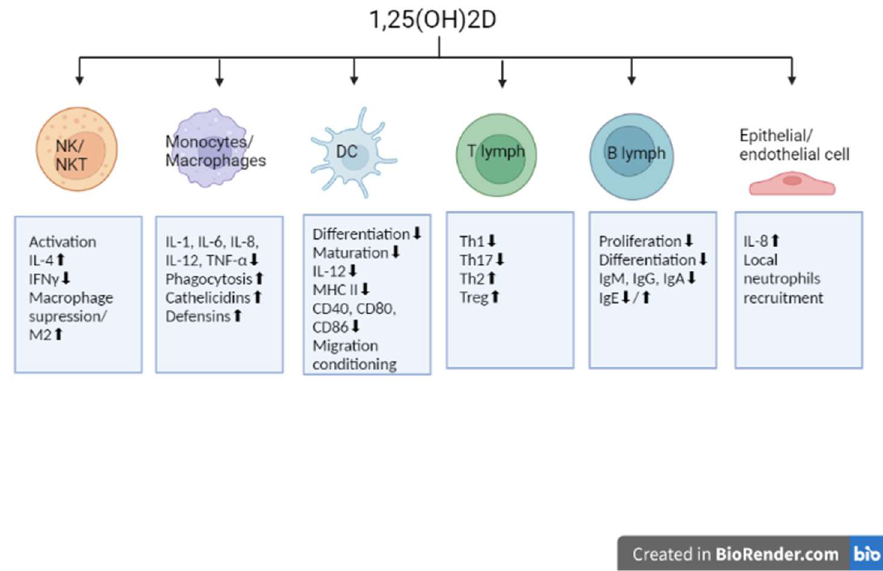
Figure 1. Immunomodulatory effect of 1,25(OH)2D on selected cells. NK, natural killer; NKT, natural killer T; DC, dendritic cell; T lymph, T lymphocyte; B lymph, B lymphocyte. Created with BioRender.com.